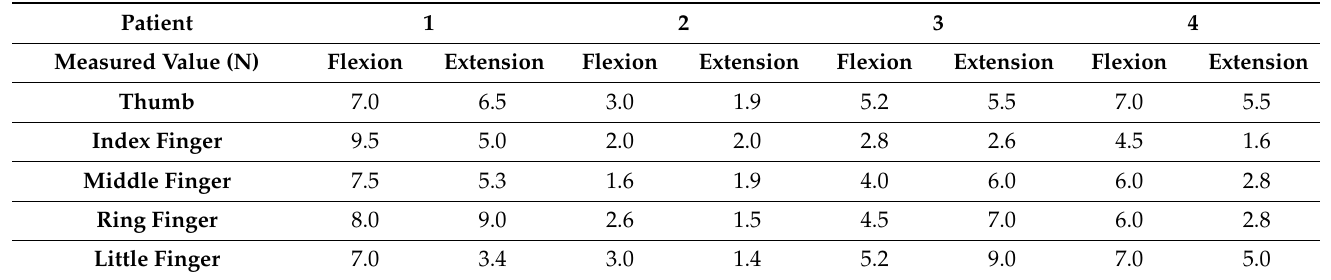
Table 4. Measured exerted forces on pathological